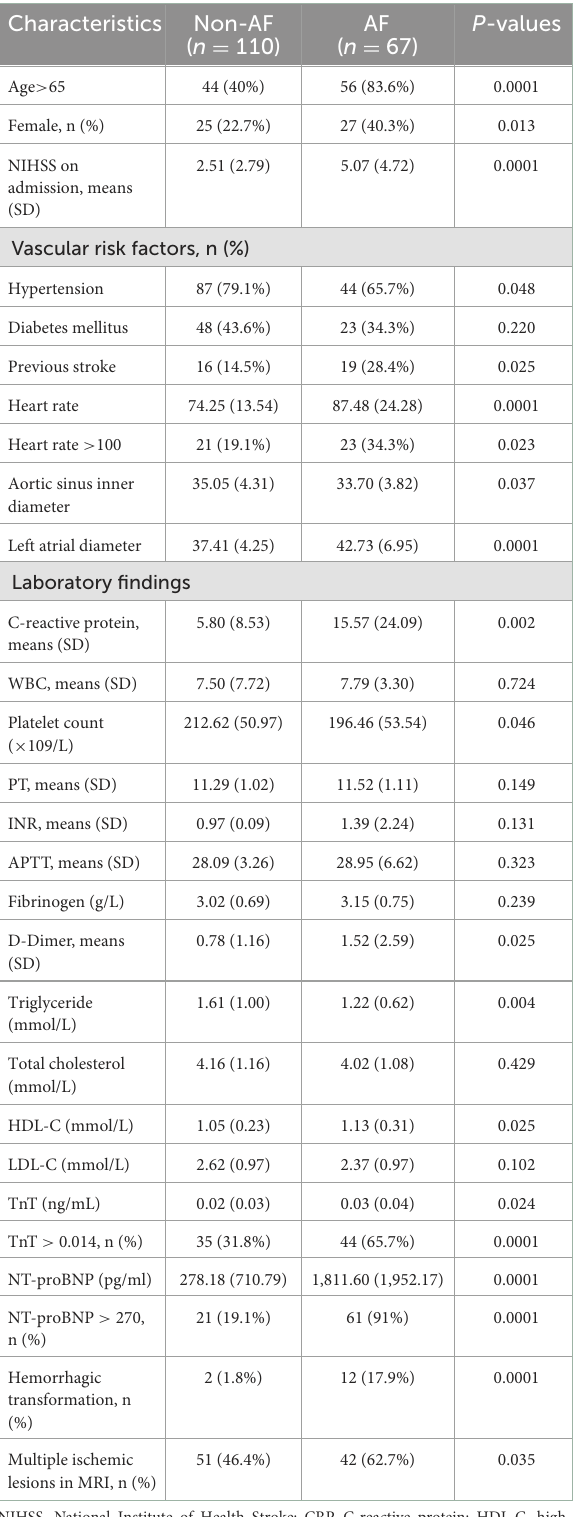
TABLE 1 Baseline and procedural characteristics. TABLE 2 Multivariate analysis for predictors of AF-related